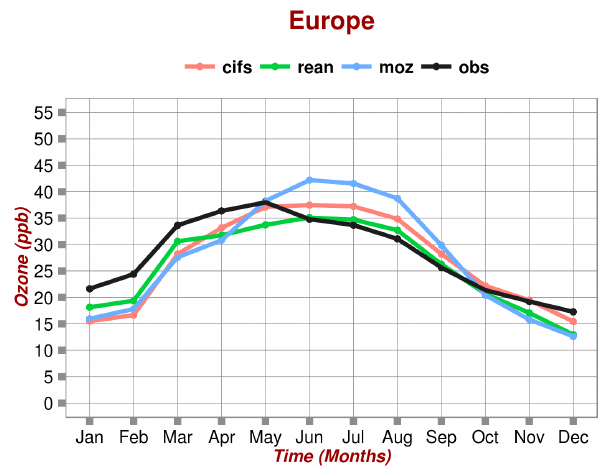
Figure 4. Annual cycle of the mean ozone volume mixing ratios (ppb) at rural sites of the EMEP and AirBase database and simulated by C-IFS (red), MOZ (blue) and REAN